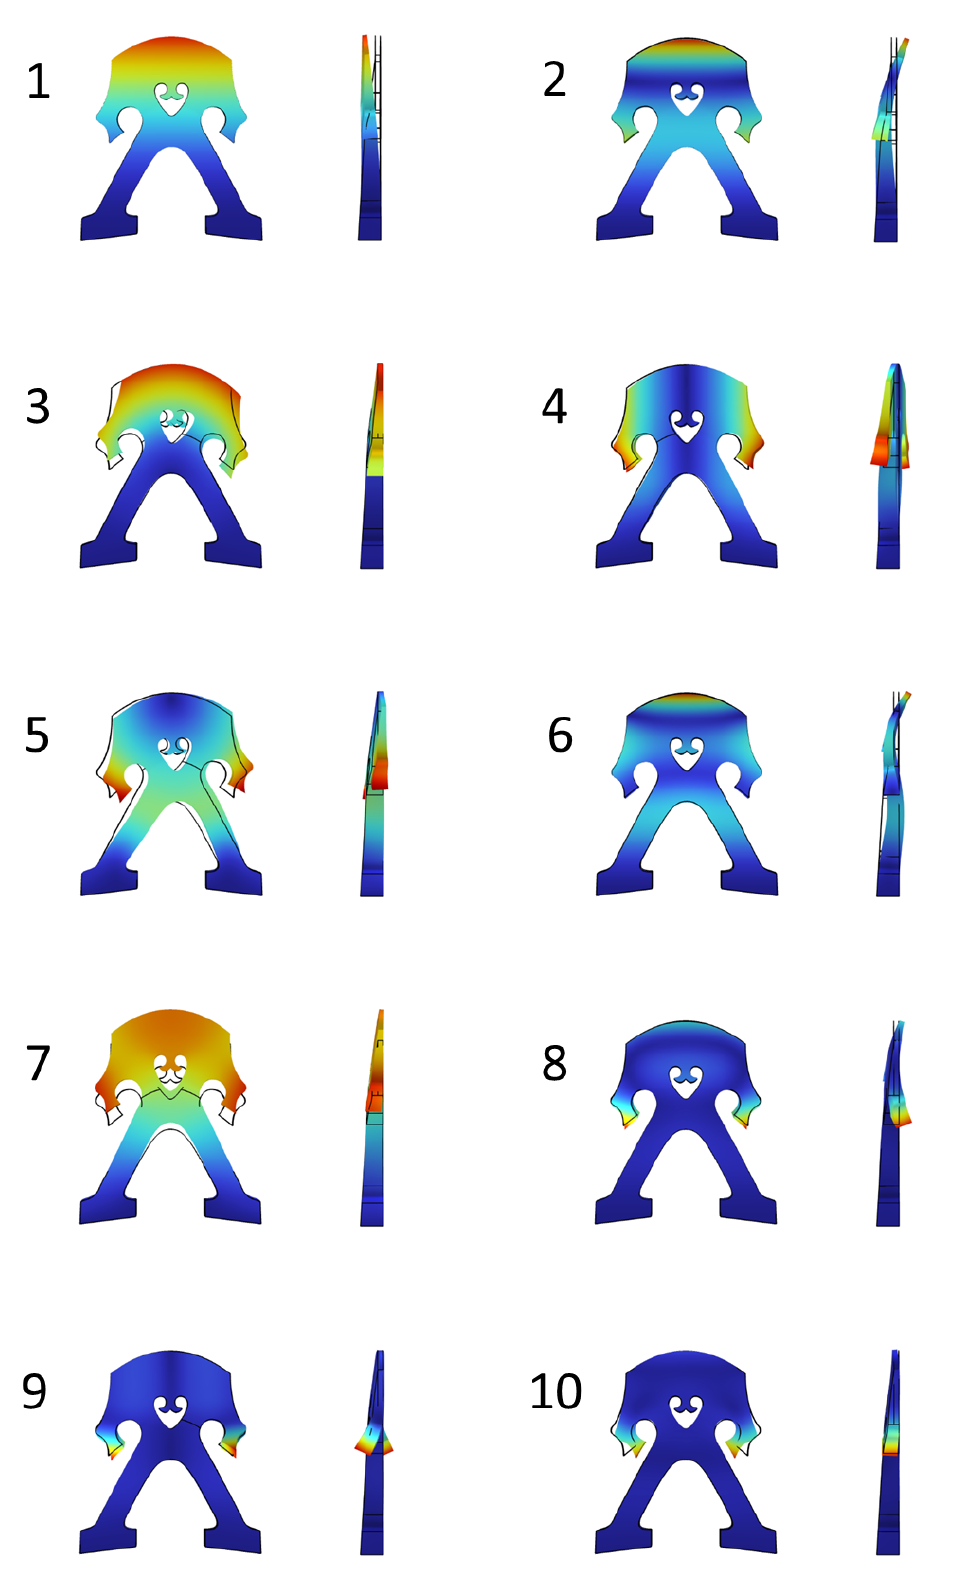
Figure A5. Mode shapes in fixed boundary conditions (case (b)) for Model